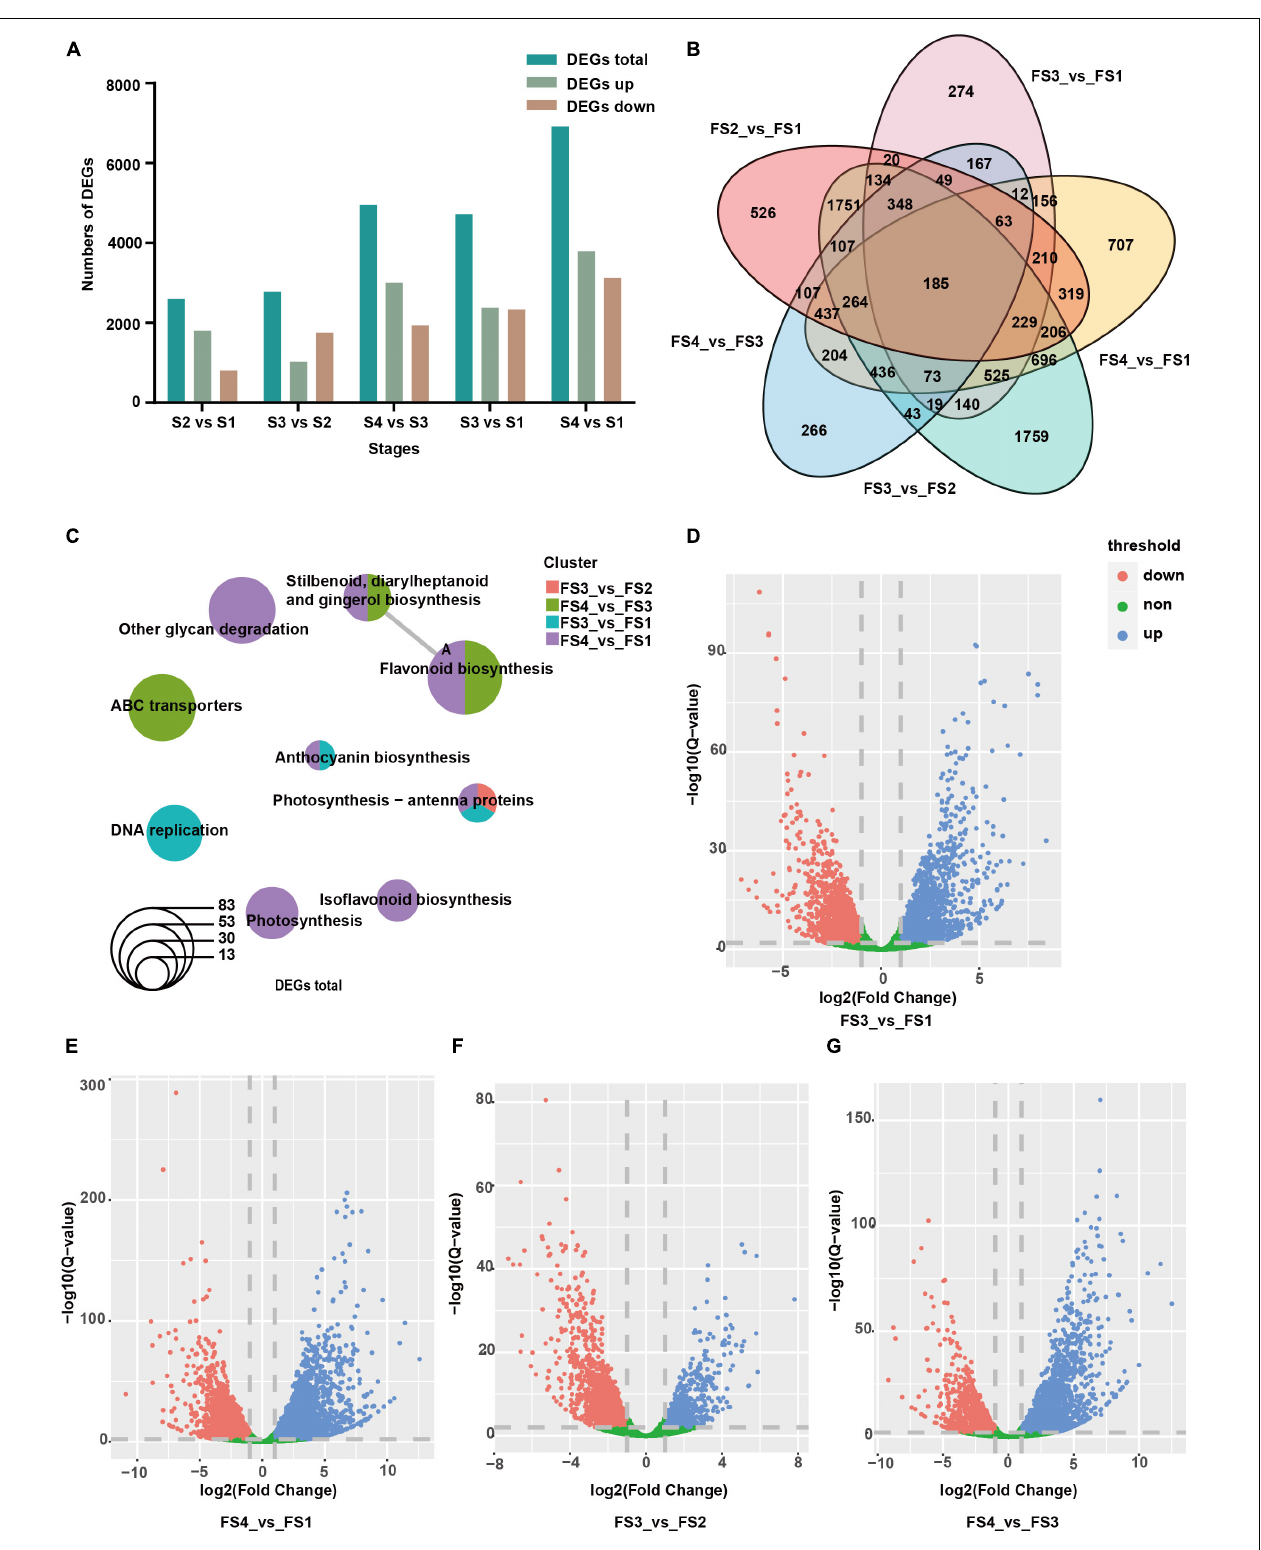
FIGURE 4 | (A) Overview of DEGs and their pathway enrichment based on KEGG analysis. Numbers of differentially expressed genes (DEGs) in five comparisons; (B) Venn diagram of the number of DEGs revealed by five comparisons; (C) KEGG enrichment of all DEGs; (D–G) Volcanic maps for DEGs in four comparisons enriched by KEGG. Red dots, downregulated genes. Blue dots, upregulated genes. Green dots, non-differential genes.